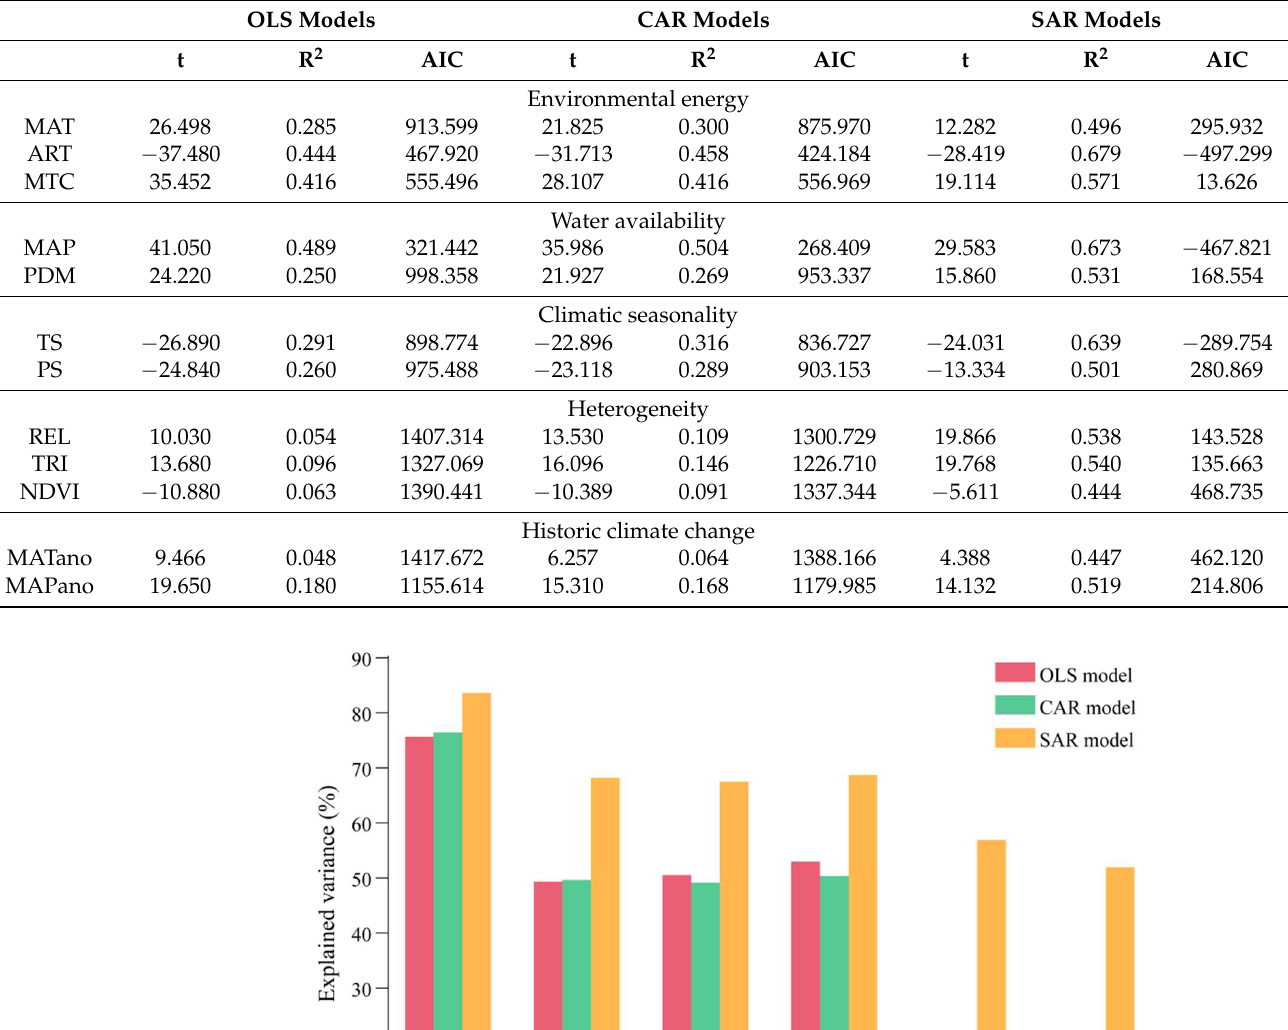
Table 1. Relationships between the richness of endemic taxa of Viburnum and explained variables using simple ordinary least squares (OLS) model, simple conditional autoregressive (CAR) model and the simultaneous autoregressive in (SAR) model.